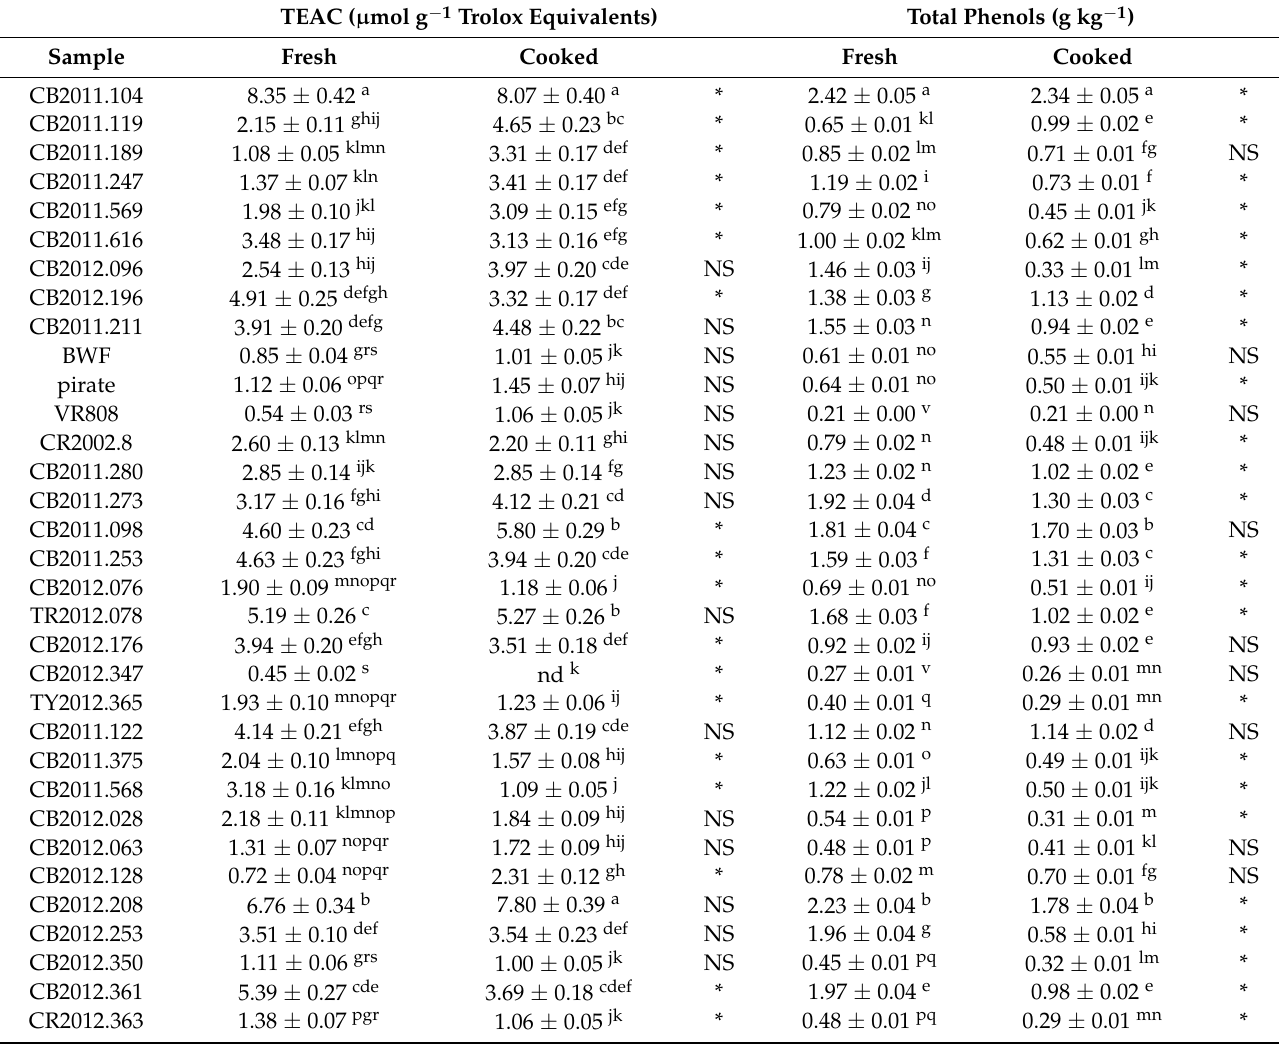
Table 2. Antioxidant activity (trolox equivalent antioxidant capacity (TEAC)) and total phenols (Folin–Ciocalteau method) in fresh and cooked white and colored potatoes. All concentrations are expressed as fresh